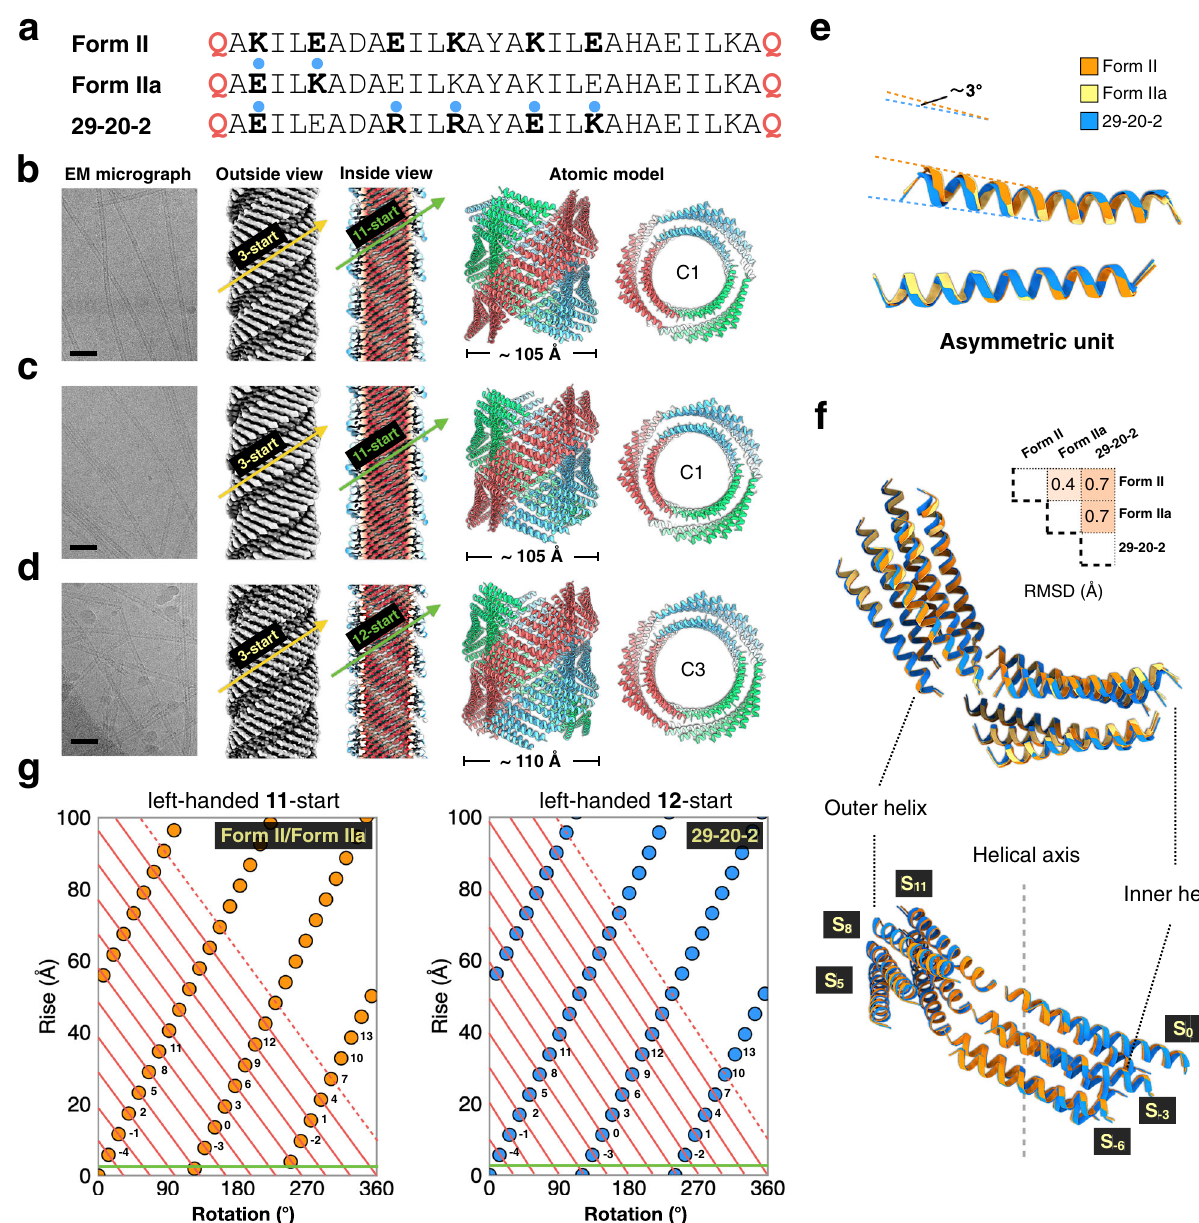
Fig. 5 Structural comparison of the Form II-like peptides. a Sequences of Form II, Form IIa and 29-20-2 peptides. Residues changed from original the Form II sequences are highlighted with blue dots. b – d Cryo-EM of peptides Form II, Form IIa, and 29-20-2. Representative raw micrographs are shown on the left (scale bar 500 Å) out of a total number of 171, 233, and 347 images recorded, respectively. The cryo-EM reconstructions are shown in the middle, one view from outside highlighting right-handed 3-start helices, and another view from the inside of the nanotube lumen highlighting the left handed 11- start or 12-start helices. The side and top views of the atomic models are shown on the right. e Structural alignment of the asymmetric unit (helix-dimer) of the three peptide fi laments. f Structural alignment of six asymmetric units of the three peptide fi laments. The alignment RMSD is shown. g Helical nets for the Form II and 29-20-2 fi laments. The helical nets show the unrolled surface lattice viewed from the outside of the fi lament. The right-handed 3-start helices can be clearly discerned for each assembly, although not explicitly highlighted. The positions of the left-handed 11- and 12-start helices are identi fi ed and are de fi ned by the red lines crossing the green horizontal line. Subunits labeled n and n + 11 are connected with red